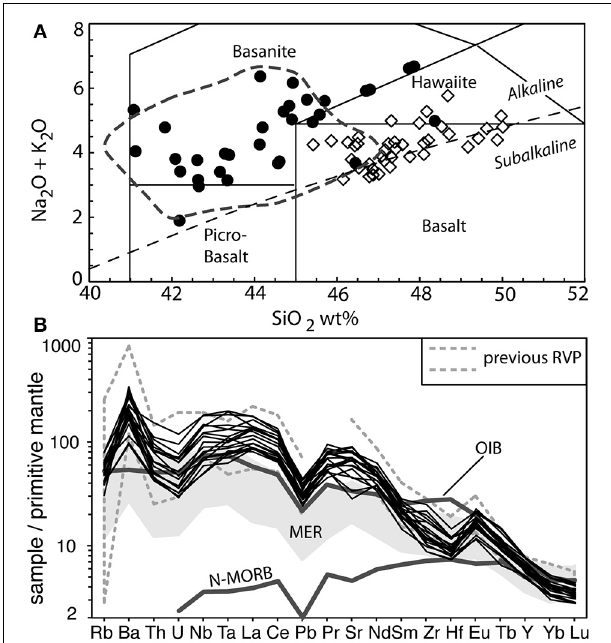
FIGURE 2 | (A) Total alkali versus silica diagram showing representative volcanic rocks from the Rungwe Volcanic Province (RVP; dark solid circles from Hilton et al., 2011; field enclosed by dash line from Furman, 1995). Lavas from the Main Ethiopian Rift (MER; open diamonds—from Rooney et al., 2012) are shown for comparison. (B) Primitive mantle-normalized trace element concentration patterns of RVP basaltic lavas and tephras (normalizing values from Sun and McDonough, 1989). Previous RVP data from Furman (1995); N-MORB is normal mid-ocean ridge basalt and OIB is ocean island basalt (from Sun and McDonough, 1989).